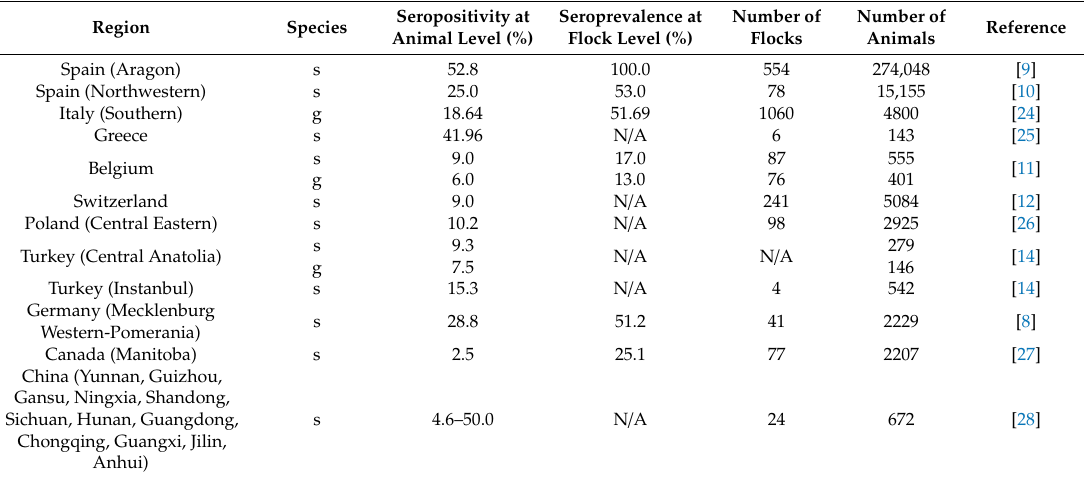
Table 1. Epizootiological studies regarding small ruminant lentiviruses (SRLVs). Region